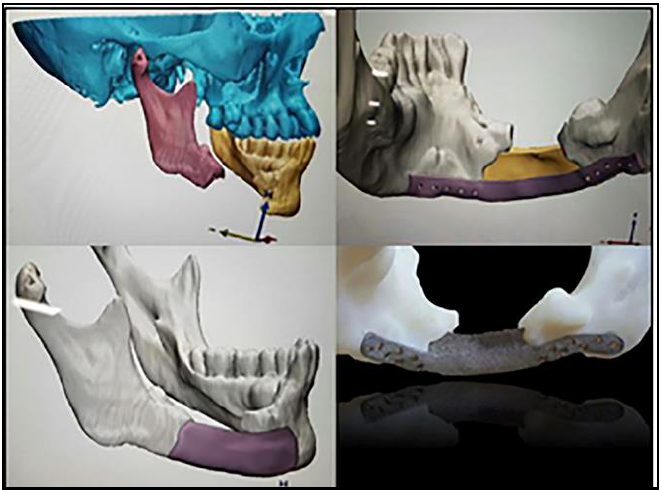
Figure 2. Pictures showing pre-operative diagnosis, virtual surgery and creation of patient-specific implants using CAD/CAM software [26]. Reproduced with permission from Ji-hyeon Oh, Maxillo- facial Plastic and Reconstructive Surgery published by Springer Nature, 2018. cial Plastic and Reconstructive Surgery published by Springer Nature,